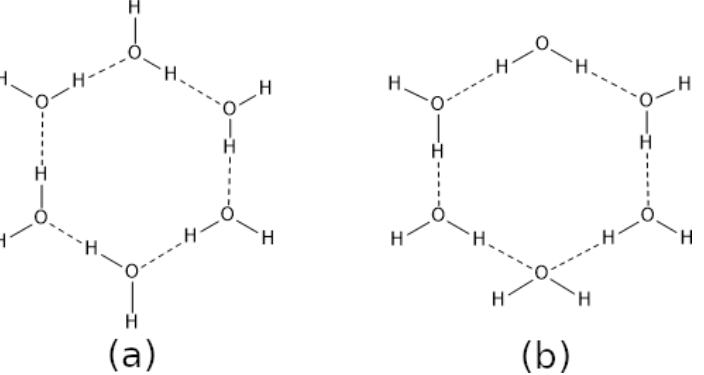
Figure 1. ( a ) Homodromic and ( b ) antidromic cycles within the structure of (H are, respectively, related to cooperative and anticooperative hydrogen bonding